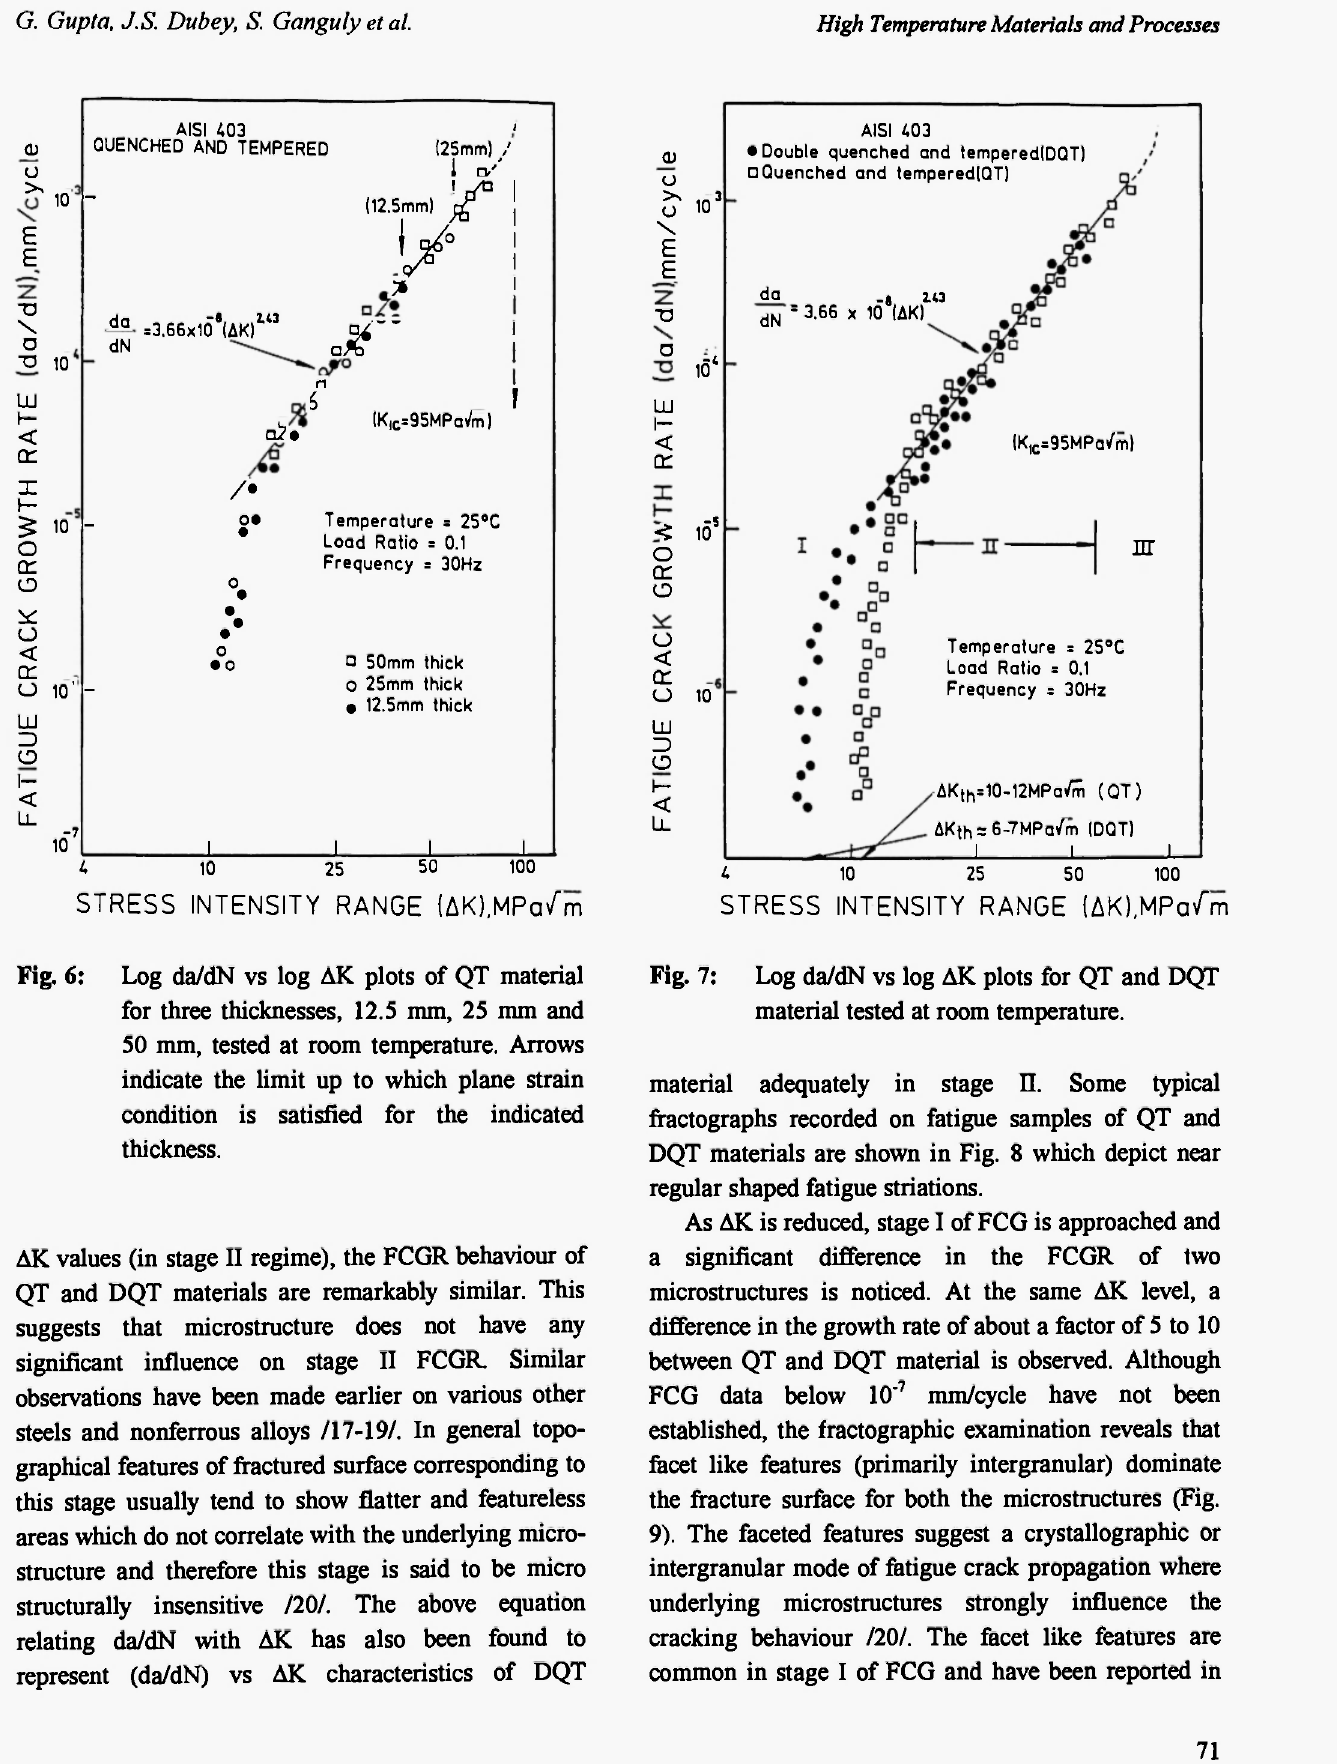
Fig. 7: Log da/dN vs log ΔΚ plots for QT and DQT material tested at room temperature. material adequately in stage Π. Some